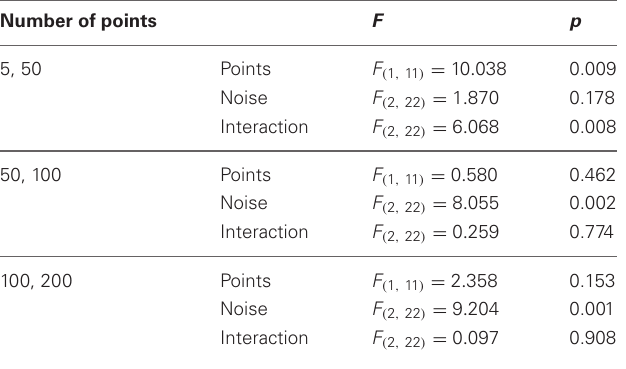
Table A2 | Results of 2 × 3 Repeated Measures ANOVA tests of the effects of flow quantity and quality at each consecutive pair of points per frame